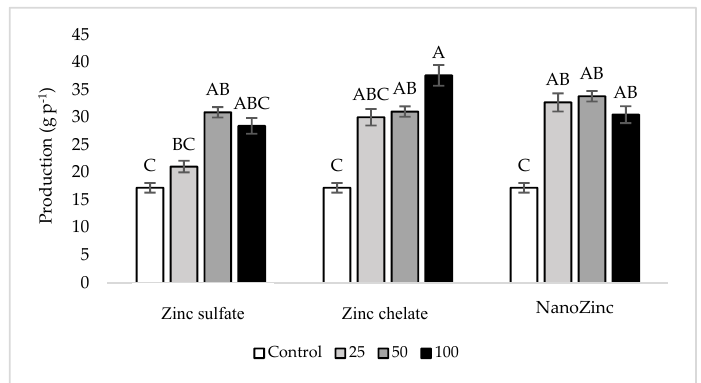
Figure 3. Effect of applying nanofertilizers, chelates, and zinc sulfates in green bean production per plant. Letters show significant differences.